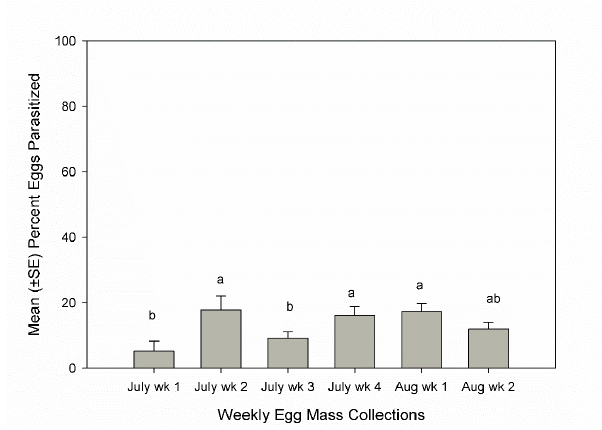
Figure 2. Mean (+SE) percent parasitism on egg masses collected weekly from squash fields, 2016– 2021, Beltsville, Maryland, USA. Weeks topped by the same letters were not significantly different (ANOVA: experiment-wise p ≤ 0.05). different (ANOVA: experiment-wise p ≤ 0.05).